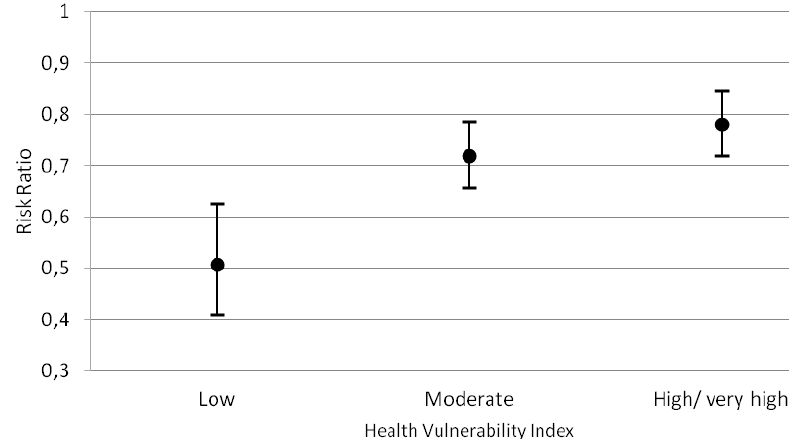
Figure 5. Stratified Risk Ratio of asthma-related hospitalization rates in children/adolescents, by social vulnerability level, in Belo Horizonte, Minas Gerais, Brazil, 2002–2012.